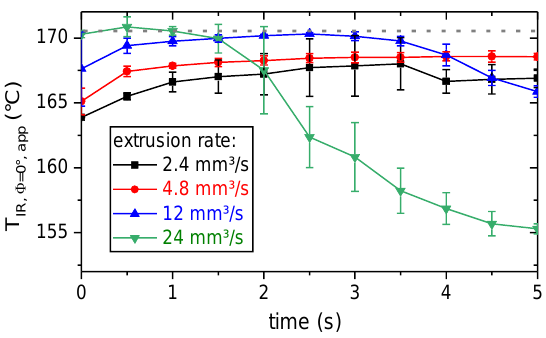
Figure 6. Apparent surface temperature, T IR, Φ=0°, app , of the PLA right below the extrusion nozzle for different extrusion rates, determined by thermography based on an assumed emissivity of 1.